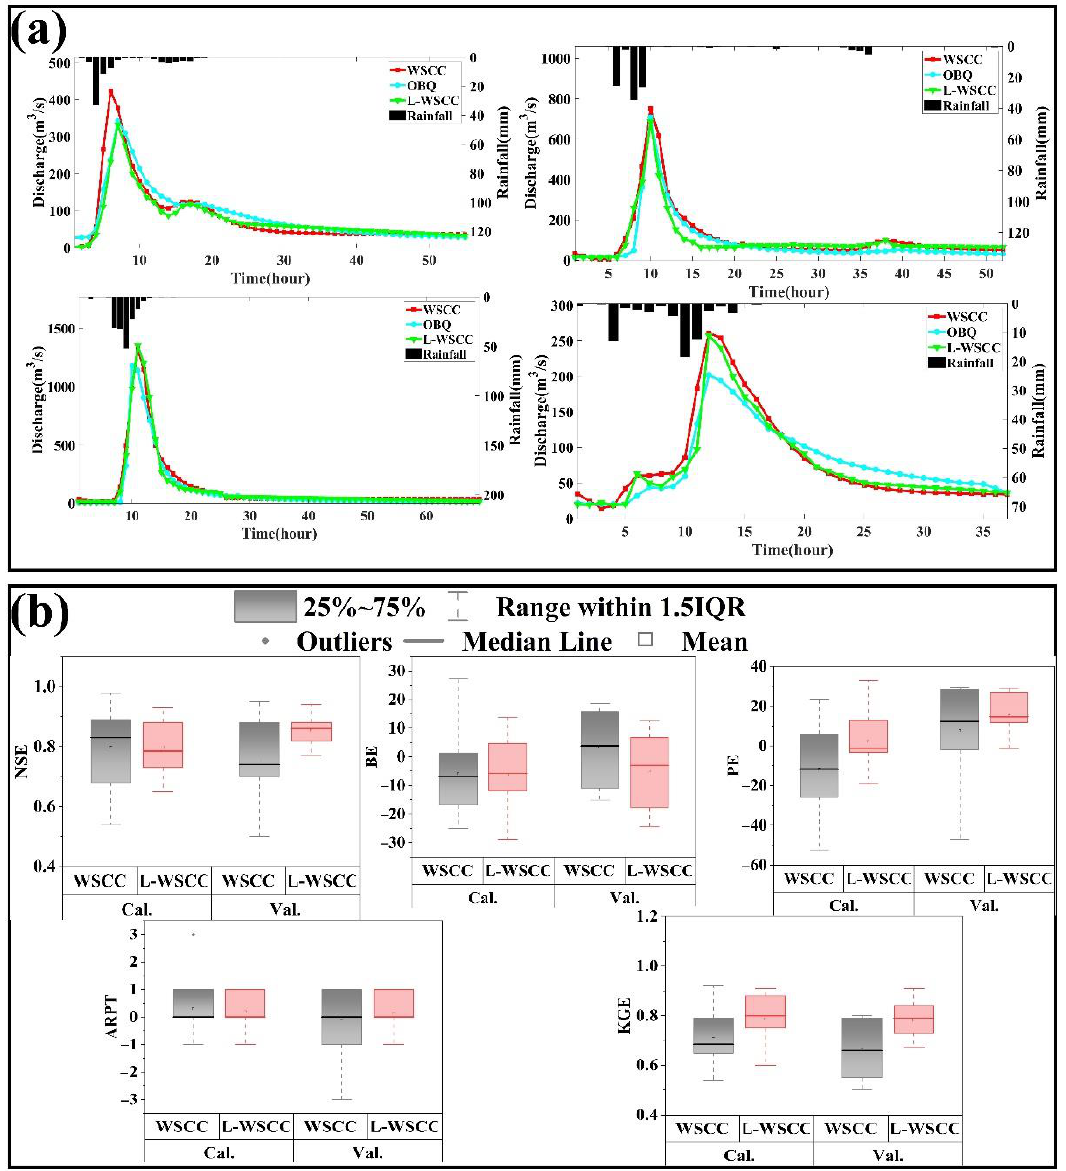
Figure 4. The simulation results on daily scale. ( a ) Observed and simulated hourly discharge (occurred on 2 April 1982; 5 May 1985; 19 May 1986; 26 May 1987 in turn, OBQ: observed values). ( b ) Boxplot graph of evaluation results (BE, PE and ARPT are absolute values).